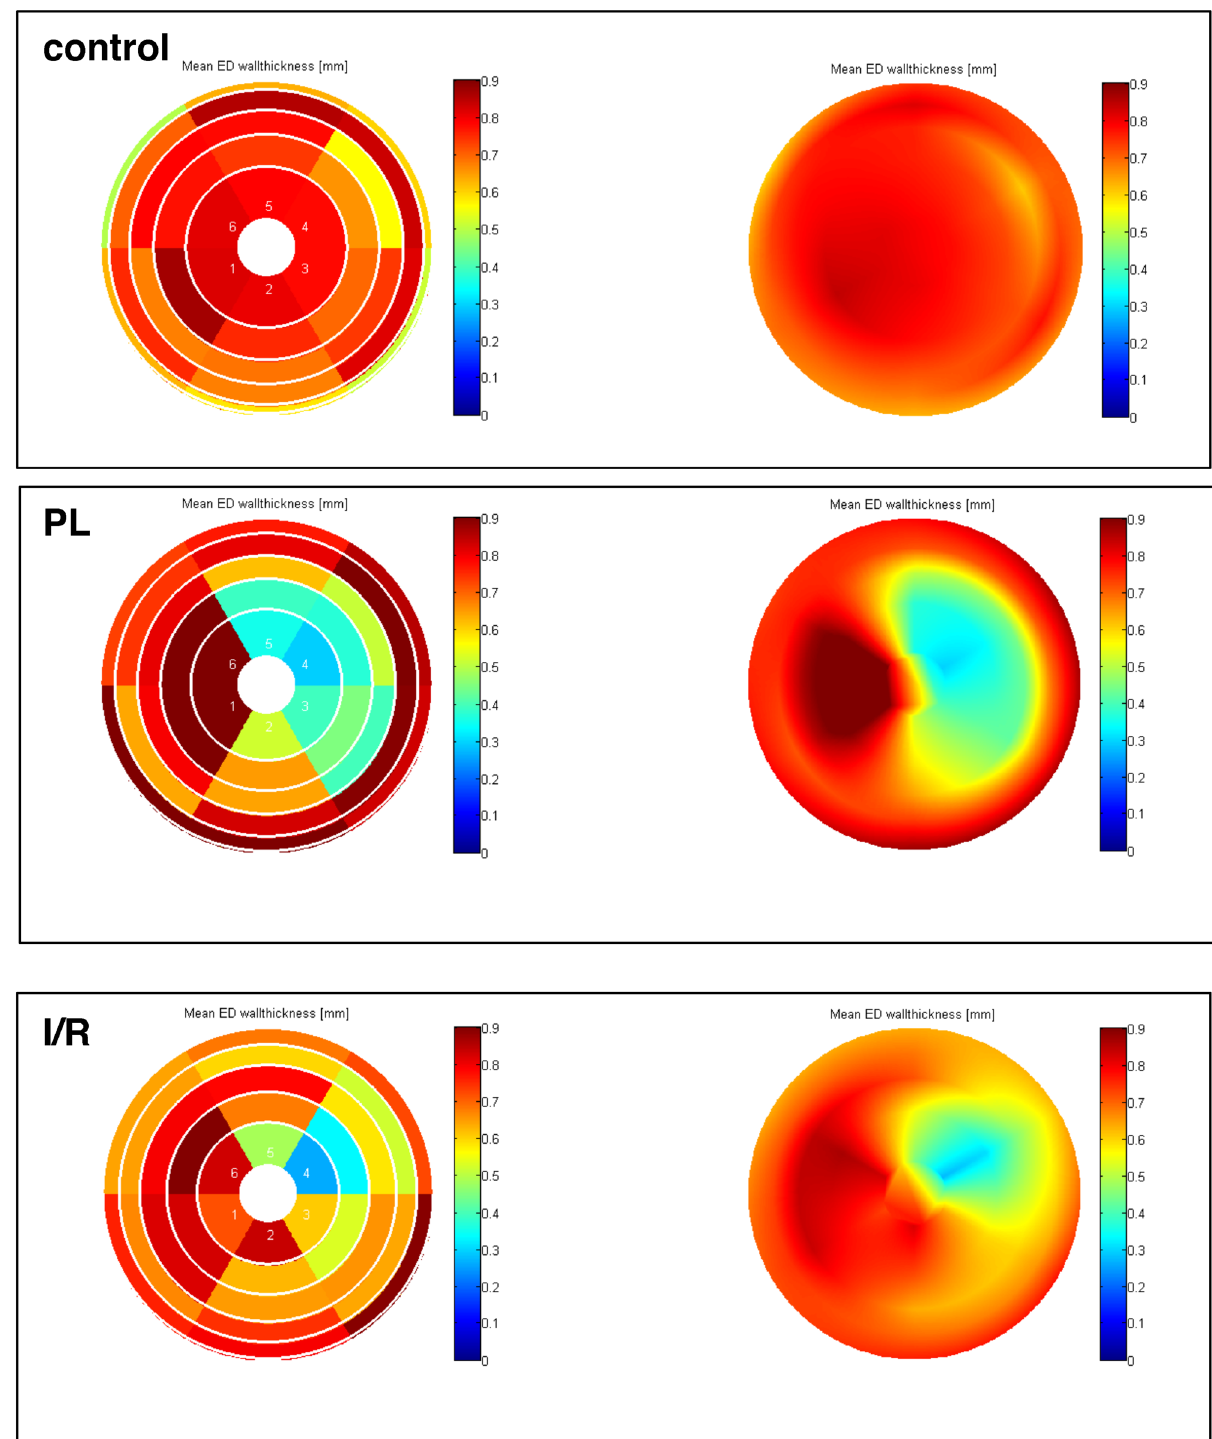
Figure 6. Polar plots of the left ventricle for visual and qualitative assessment of LV wall thickness. Each ring represents one short-axis slice. The apical slice 5 is located in the middle. The basal slice 1 is the outer ring. The “smooth bulls eye view” (right side) visualizes the aneurysm formed in the lateral